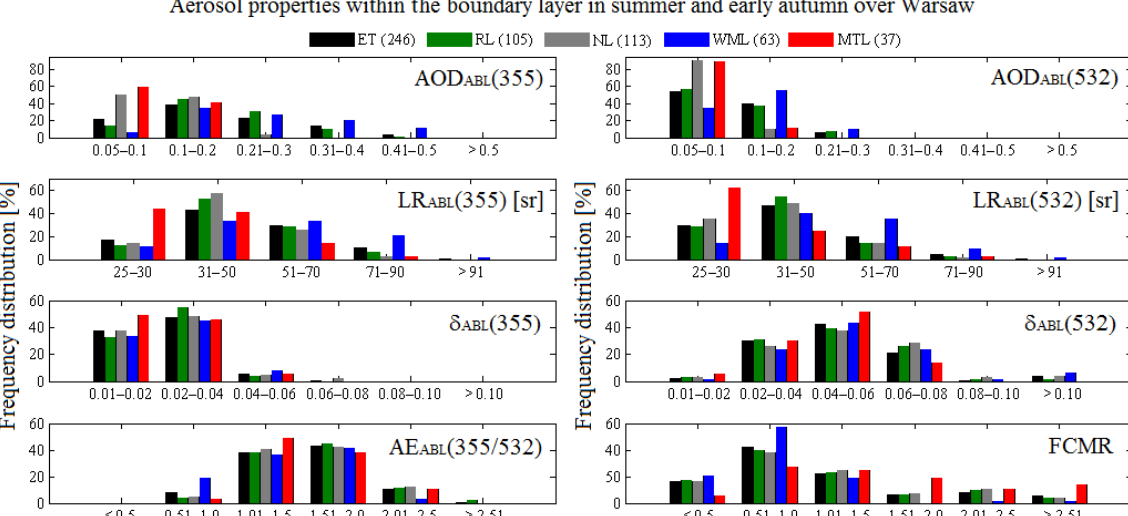
Figure 2. Frequency distribution of the aerosol optical depth (AOD), the lidar ratio (LR), the linear particle depolarization ratio ( δ ), and the Ångström exponent (ÅE) at 355 and 532nm derived within the atmospheric boundary layer at the EARLINET/ACTRIS lidar site, Warsaw, for the July–September period of 2013, 2015, and 2016. The corresponding fine-to-coarse mass ratio (FCMR) derived from measurements of surface particulate matter with an aerodynamic diameter below 10µm (PM 10 ) and below 2.5µm (PM 2 . 5 ) at the WIOS site in Ursynow, Warsaw. The period of measurement is divided into the following time spans: the entire time (ET; 24h); the nocturnal time (NT), between 22:00 and 02:00UTC – including the residual boundary layer (RL) and the nocturnal boundary layer (NL); and the transition time (TT), after sunrise between 03:00 and 08:00 for the morning transition layer (MTL) and before sunset between 16:00 and 20:00UTC for the well-mixed boundary layer